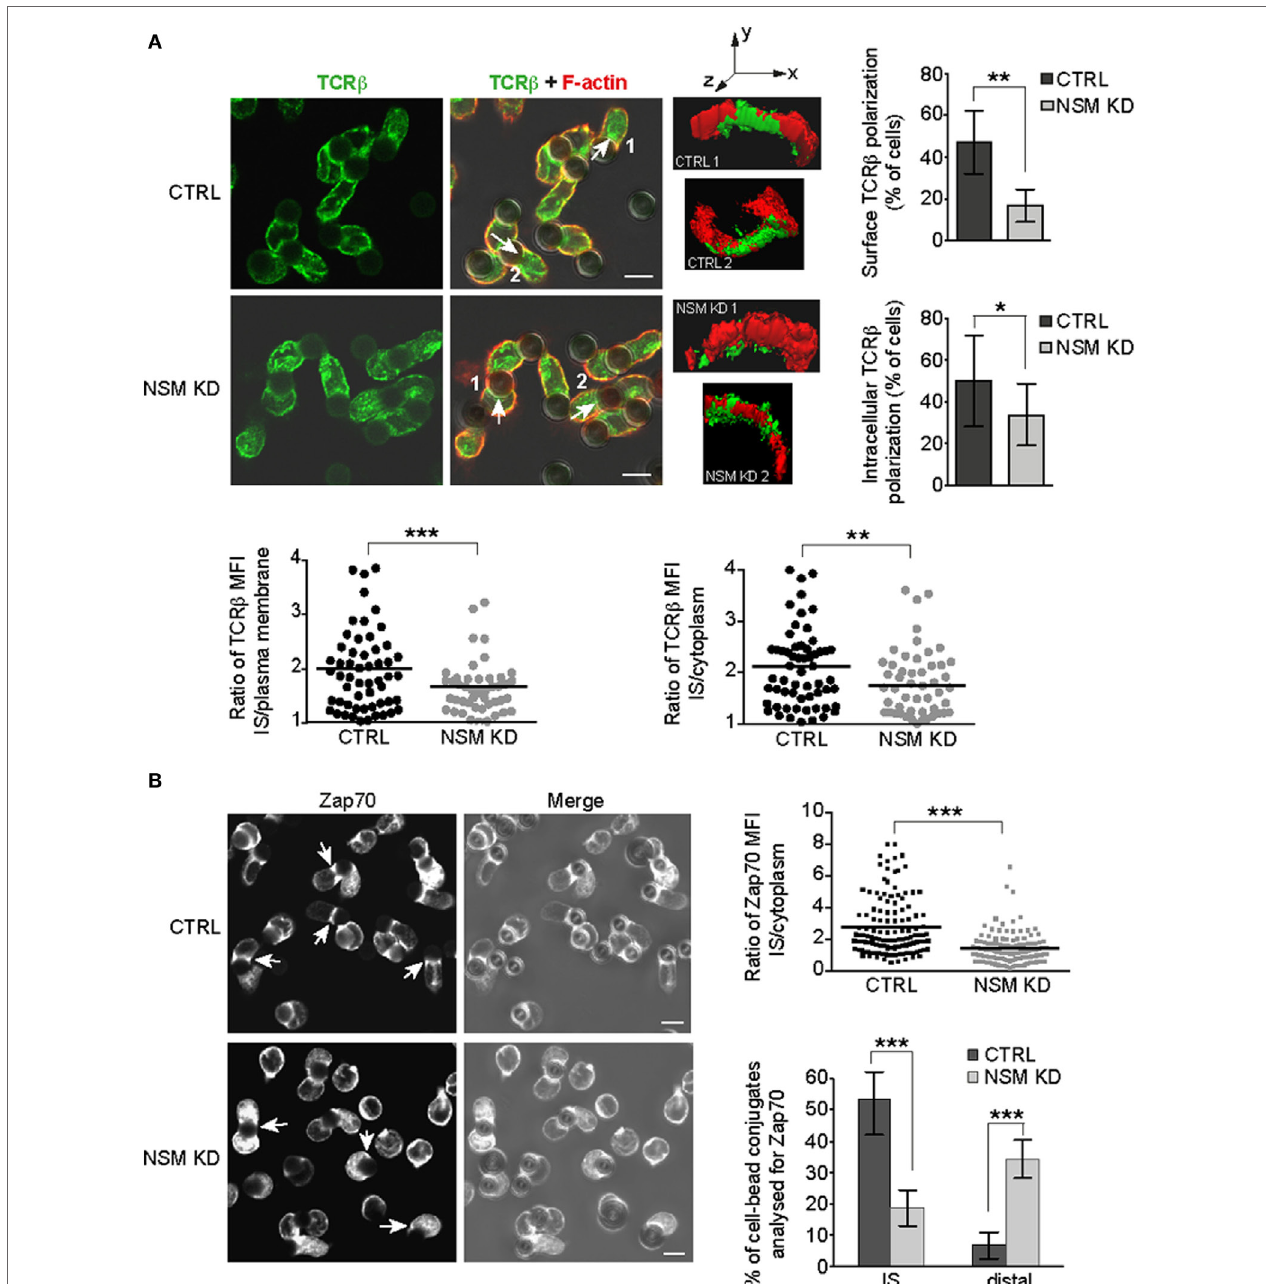
FigUre 4 | NSM activity is required for immune synapse (IS) polarization of T cell receptor (TCR) signaling components. CTRL and NSM KD cells were stimulated by α -CD3-coated beads and redistribution of TCR β (a) and Zap70 (B) was determined after 15 min. (a) TCR β was co-detected with F-actin (IF shown in left panels, right panels showing 3D reconstruction of the cell-bead IS areas indicated in the IF merge pictures by numbers and arrows). IS interface accumulation was counted as positive if relative fluorescence increase at IS of each individual cell (depicted in scatter plots) was more than 1.5 in relation to surface fluorescence intensity or intracellular accumulation. The results are shown as % of cells with positive interface accumulation of TCR β (column bar graphs). (B) Zap-70 redistribution was analyzed as in (a) with regard to relative IS recruitment of the intracellular pool. In addition, Zap-70 re-positioning to the distal pole was observed in NSM KD cells where fluorescence intensity was more than two times higher in cell region most distal to the cell-bead interface (right bottom graph). (a,B) Size bars represent 5